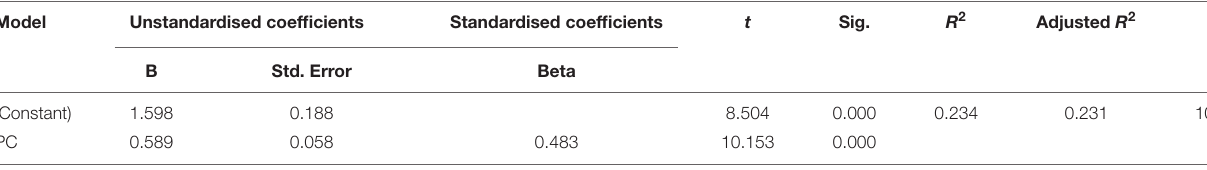
TABLE 9 | The influence of PC variables on EI. Model